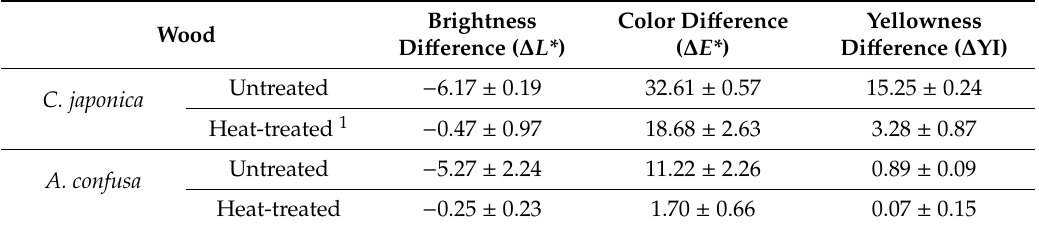
Table 4. Lightfastness of untreated and heat-treated Japanese cedar ( Cryptomeria japonica ) and Formosa acacia ( Acacia confusa ) wood finished with polyurethane (PU) coating.